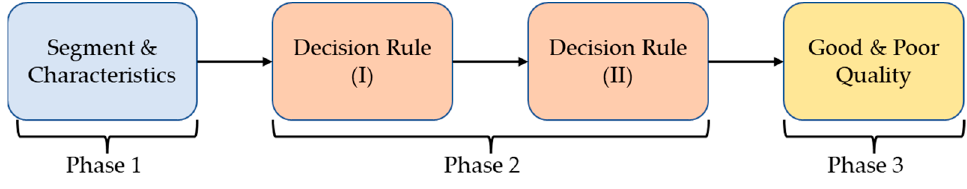
Figure 3. The flowchart of pulse quality analysis. Phase 1 is the pulse segmentation and the four characteristics determination. Phase 2 is to apply the decision rules for evaluating the pulse quality. Phase 3 is to mark the quality of each